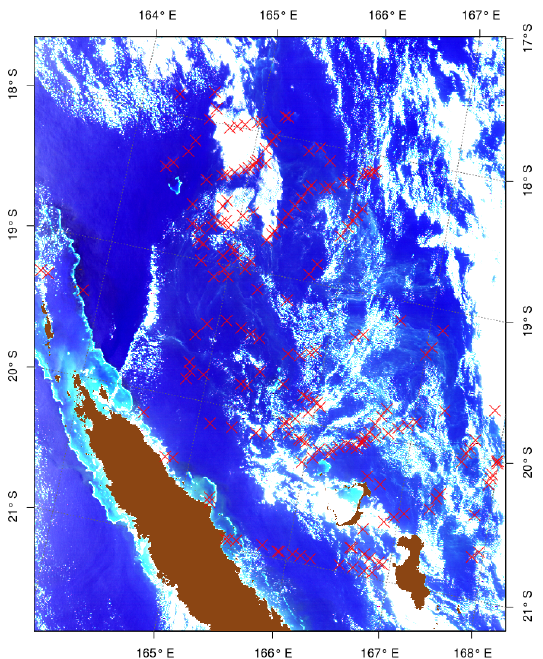
Figure 3. True color image of 17 December “2014A2014351.0255” for which in situ observations (red crosses) exist in the OBT database, and it was used for the test and adjustment of the different bio-optical